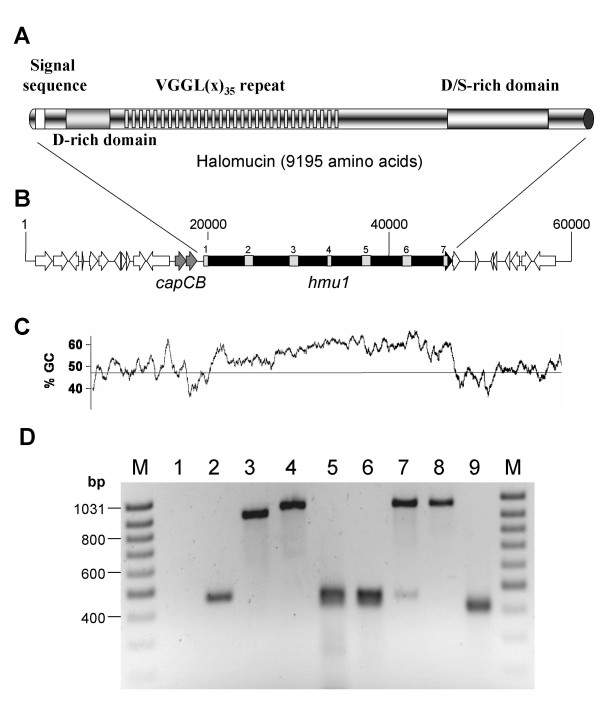
H. walsbyi encodes halomucin, an extremely large protein homologous to mammalian mucins. GC content (C) and gene organization (B) of a 60.000 bp long region of the genome of H. walsbyi. This region contains the large, high GC gene encoding halomucin (hmu1) and the two capsular protein biosynthesis genes capC and capB. The domain organization of halomucin (A) reveals domains typically found in mammalian mucins. The letters D, S, V, G, and L indicate domains enriched for the corresponding amino acids. Halomucin expression is shown by detection of its mRNA via RT-PCR (D). cDNA was prepared by reverse transcription using primer sets numbered 1 to 7 the position of which correspond to the striped and numbered boxes in the hmu1 gene (B).